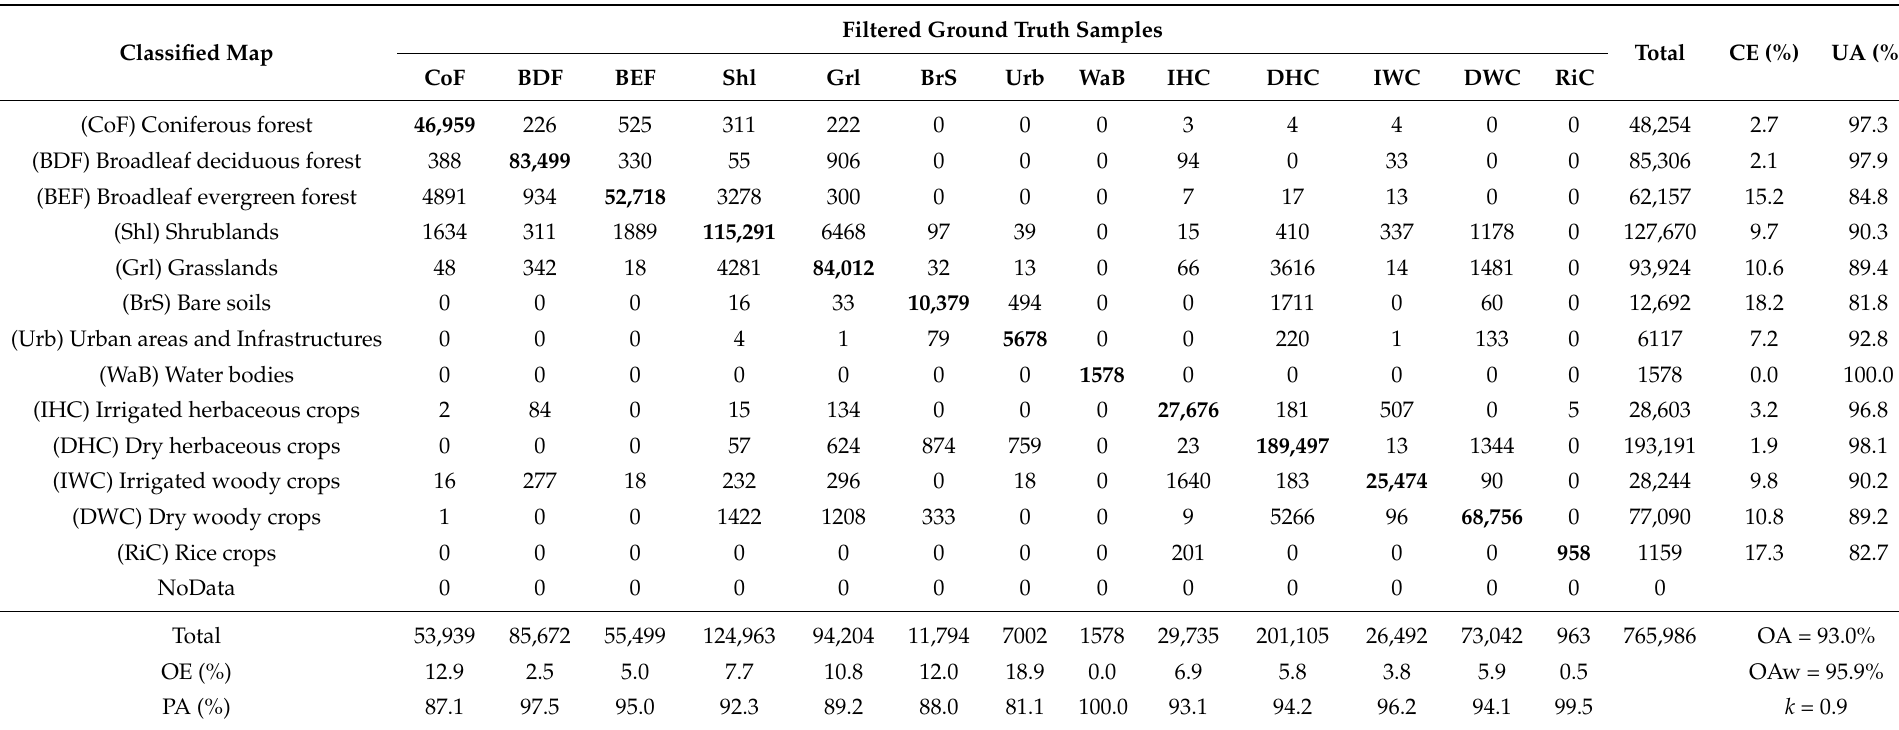
Table 3. Confusion matrix results derived from filtered ground truth samples from SIOSE 2005 rDS and imagery for